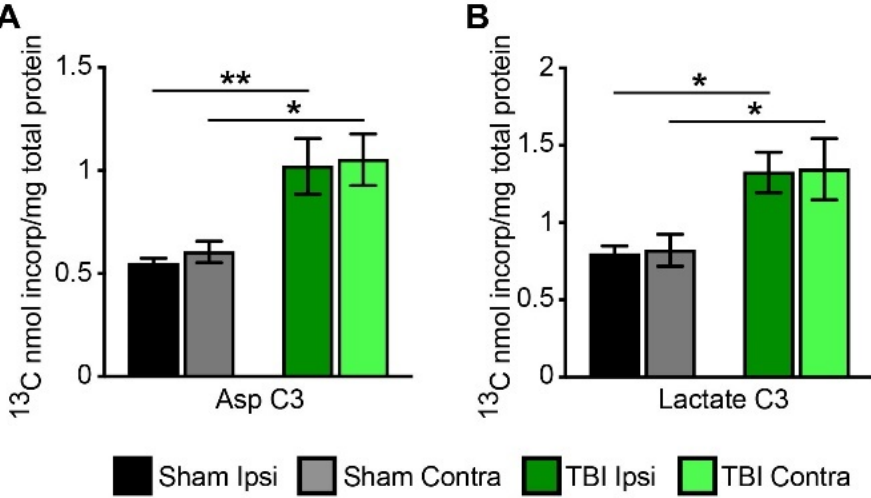
Figure 5. Incorporation of label from metabolism of [2,4- 13 C] β -hydroxybutyrate ( 13 C-BHB) into aspartate (Asp C3) ( A ) and lactate (Lac C3) ( B ) in ipsilateral and contralateral cortico-hippocampal formations in sham and TBI-operated animals. Values are mean ± SEM nmol 13 C incorporated/total mg of protein; n = 8 sham and n = 8 TBI. Data were analyzed by 2-way ANOVA with Bonferroni post-hoc analysis. * p < 0.05, ** p < 0.01.